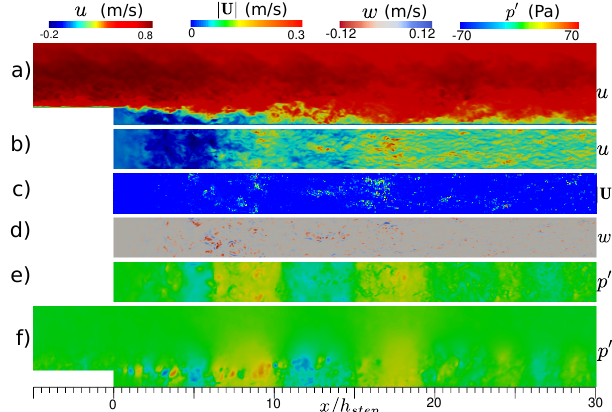
Figure 1. Visualization of the downstream fluid velocity, u ; ver- tical velocity, w ; particle velocity magnitude, | U | ; and fluid pres- sure fluctuation, p (cid:48) ; at an instant in time. (a) Downstream veloc- ity on a vertical slice at the middle of the cross-stream domain. (b) Downstream velocity on a horizontal slice at z = 1mm. (c) Par- ticle velocity magnitude. (d) Vertical velocity on a horizontal slice at z = 1mm. (e) Fluid pressure fluctuation on a horizontal slice at z = 1mm. (f) Fluid pressure at the middle of the cross-stream do- main. An animation associated with this figure can be found in the